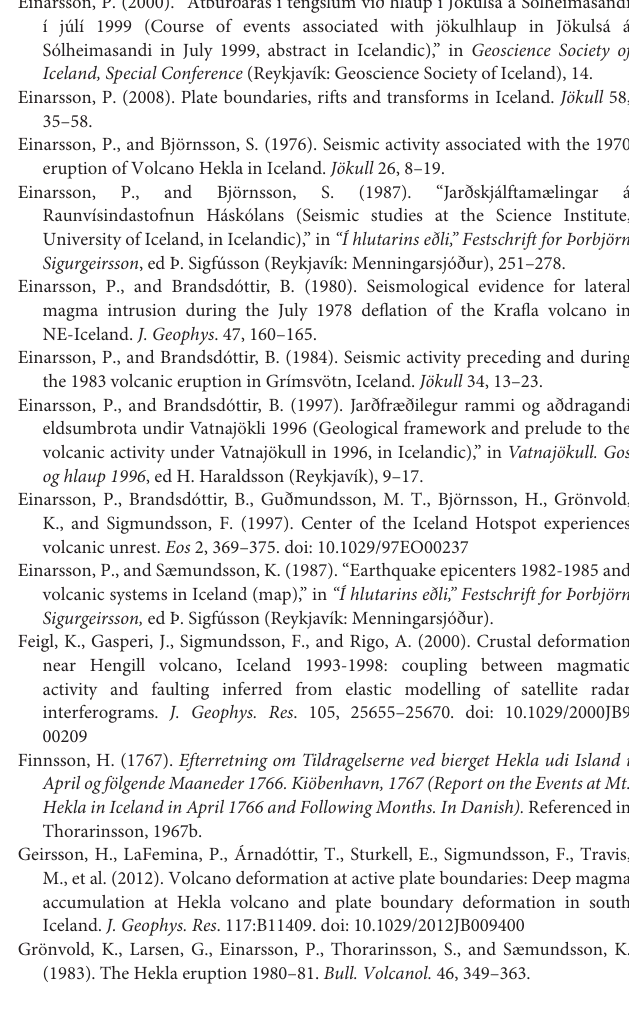
Rut Hjartardóttir made Figure 1 . The paper